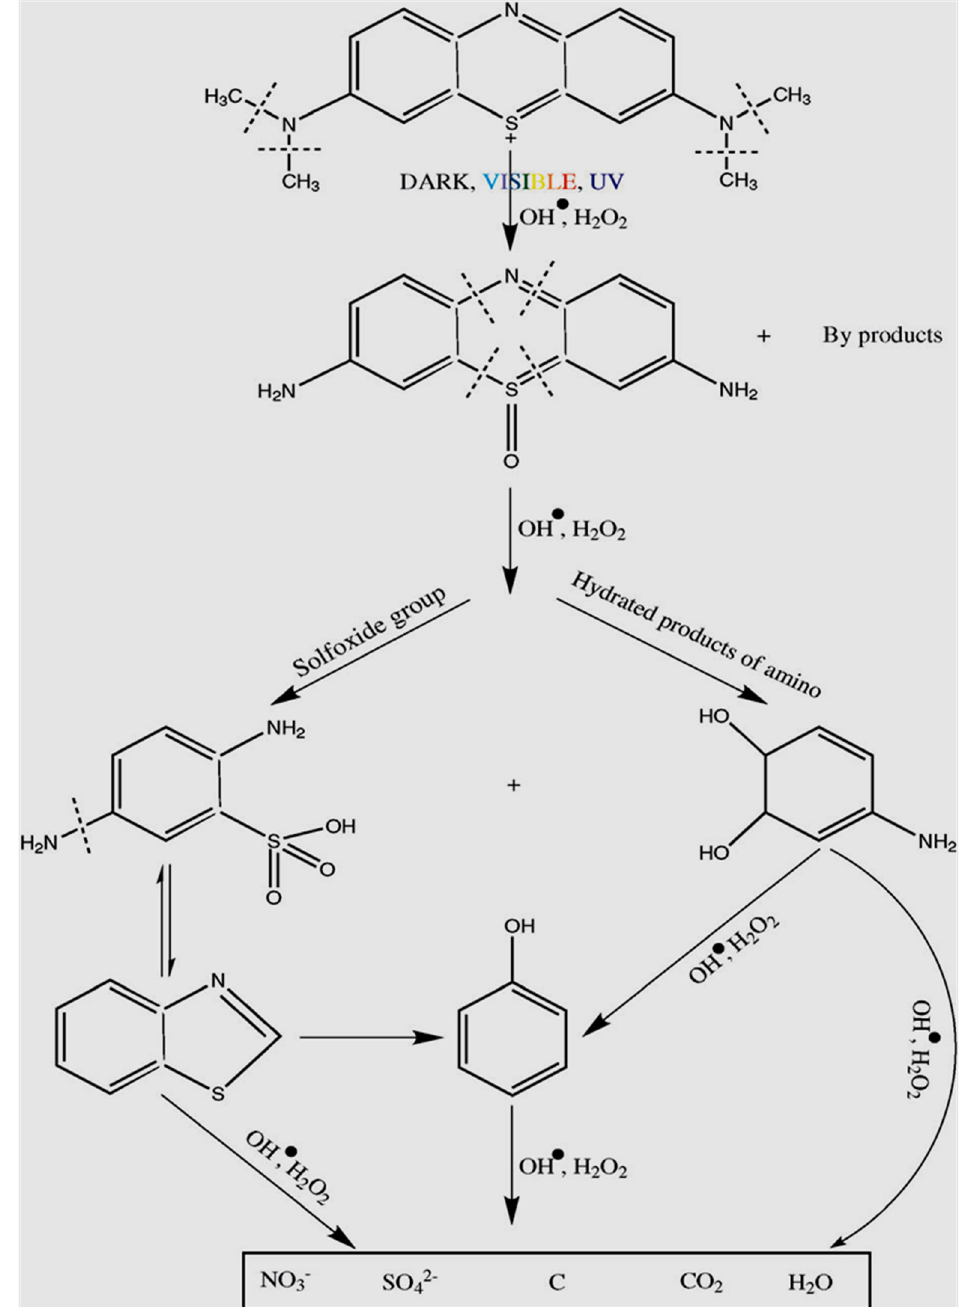
Figure 10. Proposed MB degradation pathway during the photocatalytic process [263]. Adapted with permission from Royal Society of Chemistry (license ID 1080130-1).